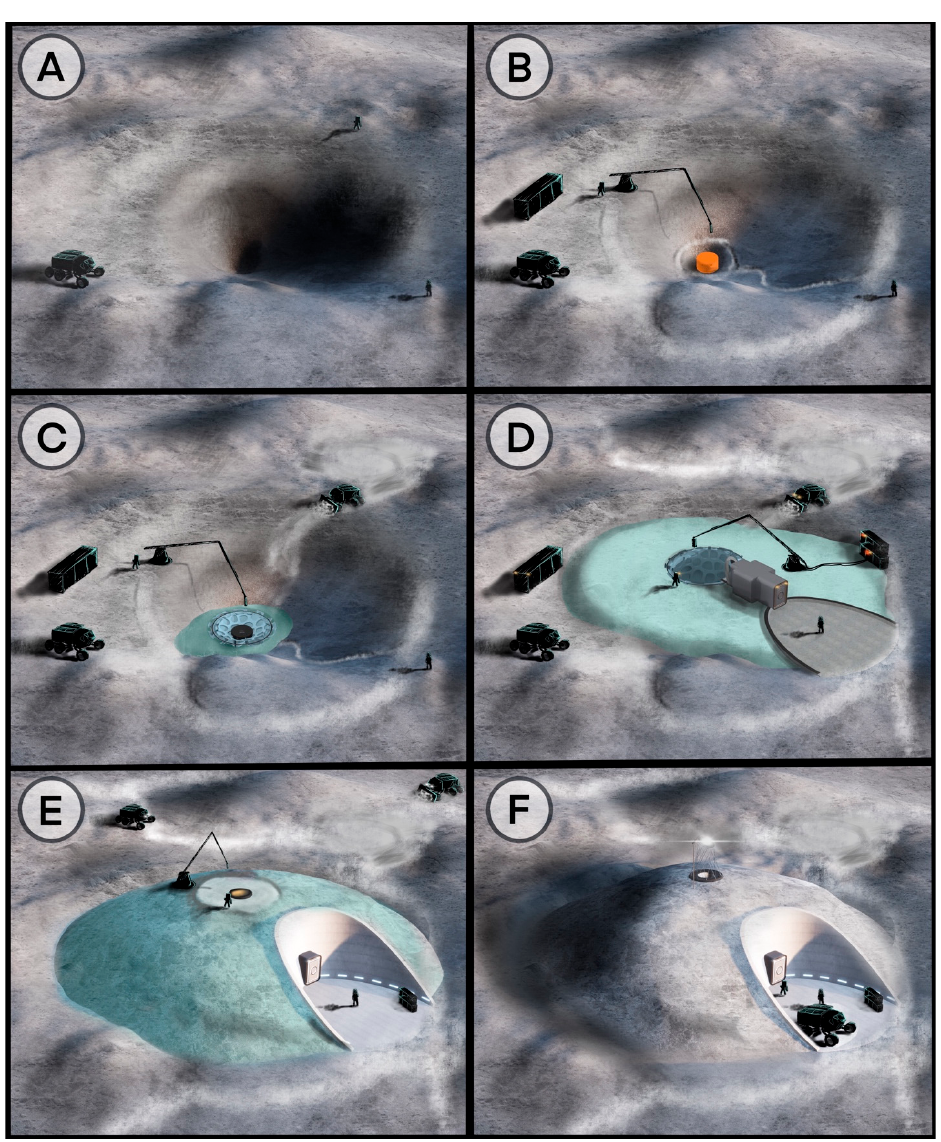
Figure 7. A view of a Lunar habitat construction procedure divided into six phases ( A – F ).